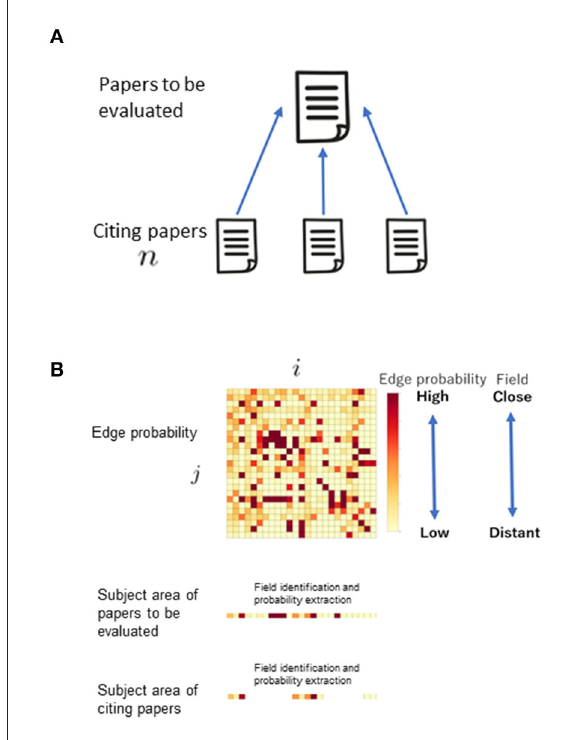
FIGURE5 Calculation of distance between fields. (A) Papers to be evaluated and papers citing them. (B) Acquisition of distance between fields expressed in terms of connection (edge) probability. To calculate REDi score, the fields were identified first, and then the probability for each connection were extracted.